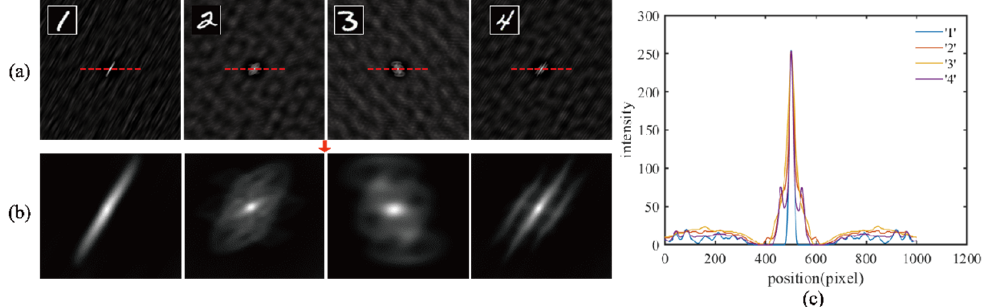
Figure 4. Autocorrelation analysis of different objects associated with the same CPM. ( a ) The autocorrelations of objects; ( b ) Enlarged partial views of ( a ); ( c ) Profiles of the red dashed lines of ( a ).